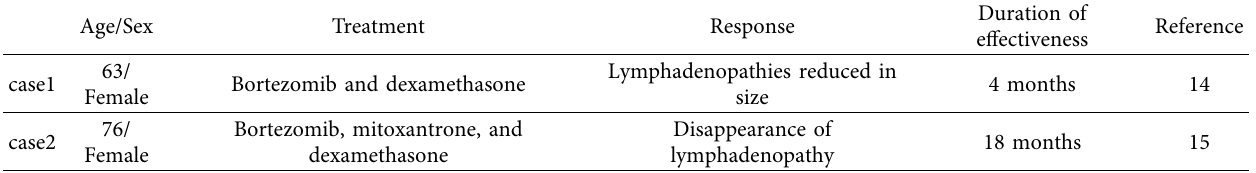
Table 1: Previous case reports of bortezomib use in angioimmunoblastic T-cell